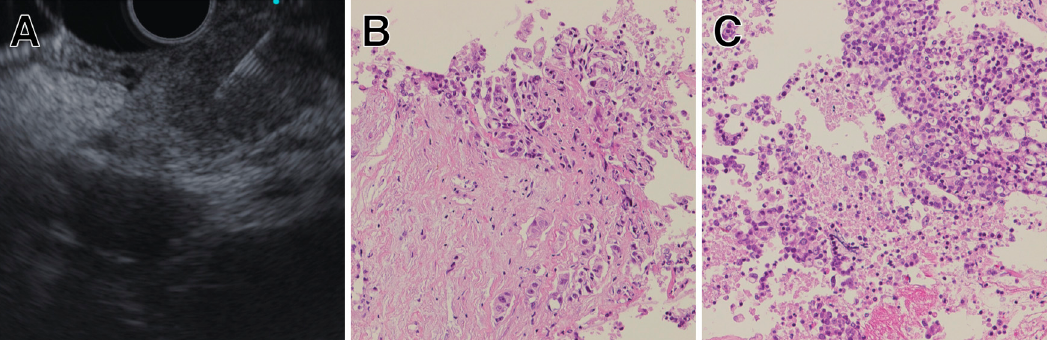
Figure 3. Representative case of EUS-TA for PC. ( A ) EUS-FNB of PC located in the tail of the pancreas. ( B ) Tissue sample from primary tumor containing more stromal cells than neoplastic cells. ( C ) Tissue sample from lymph node metastasis showing higher tumor fraction. This sample ware utilized for next-generation sequencing (NGS).